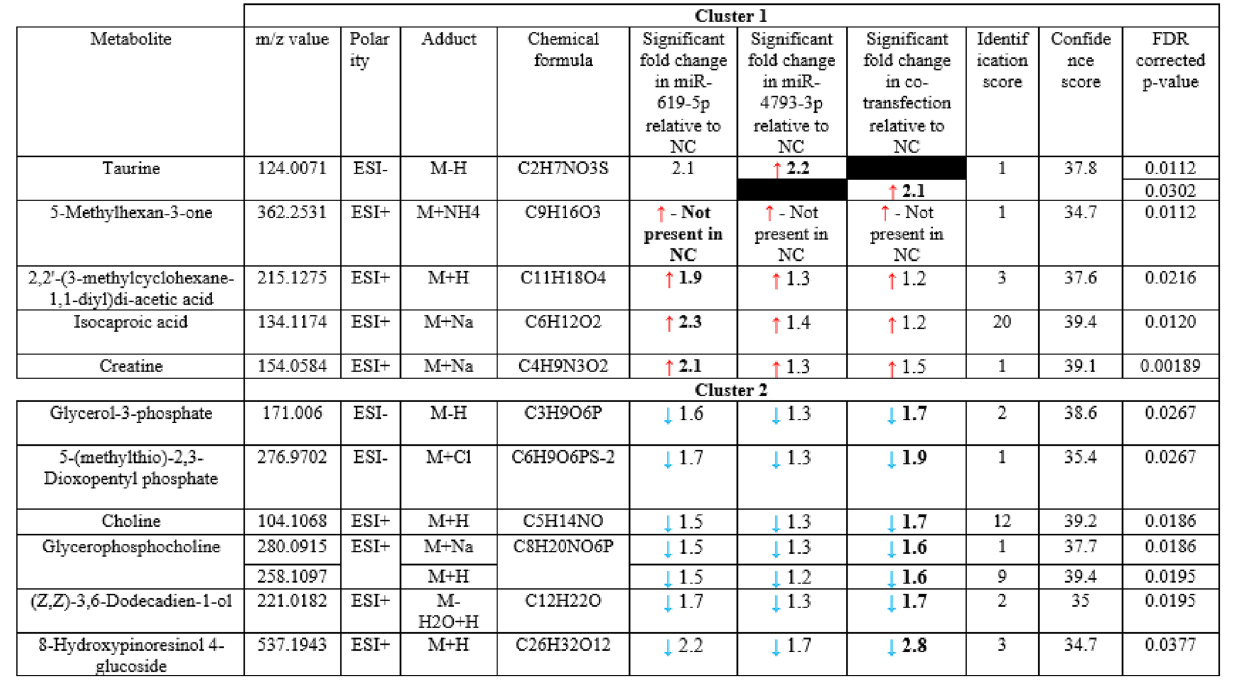
Table 2. Fold change differences for identified differentially abundant polar metabolites. Blue and red arrows represent significantly reduced or elevated metabolite levels relative to the non-targeting control (NT). Statistically significant fold changes are shown in bold. Statistical analysis was performed using a two-sided t-test, and p-values were corrected for multiple comparisons using the false discovery rate (FDR). Metabolites are identified either in the positive (ESI+) or the negative (ESI−) electrospray ionisation